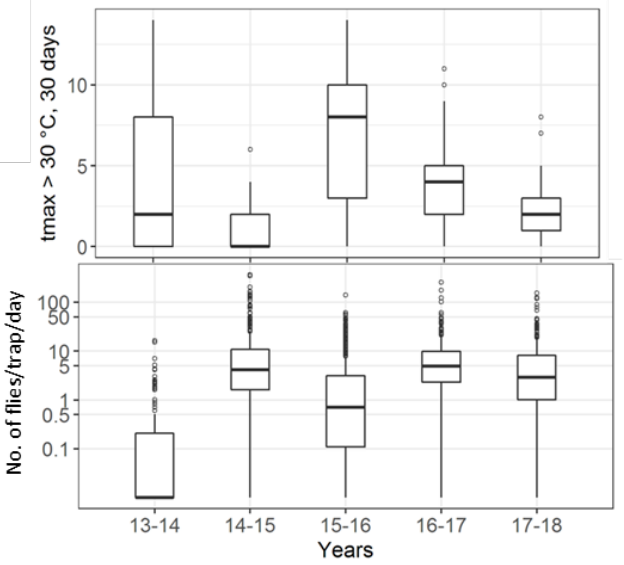
Figure 9. Summer captures: (top) the number of days when tmax > 30 °C in the 30 days before the traps were emptied for each trap deployment; (bottom) captures/day from each trap and trap deployment. Both panels are per D. suzukii -year. Note: log-scaled y-axis on the bottom panel.